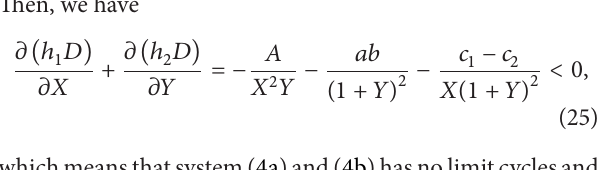
= 0.1 , and 𝑐 = 0.5 (color online). 𝑏 = 0.01 , 𝑐 1 2